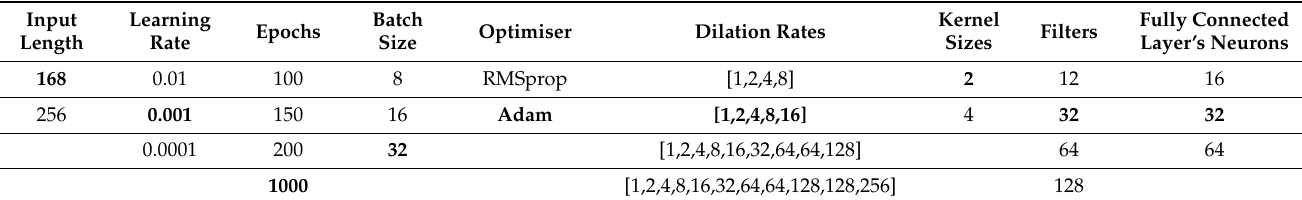
Table 1. Tested hyperparameter’s combination. The highlight parameters are the parameters combined with the lowest error in the validation